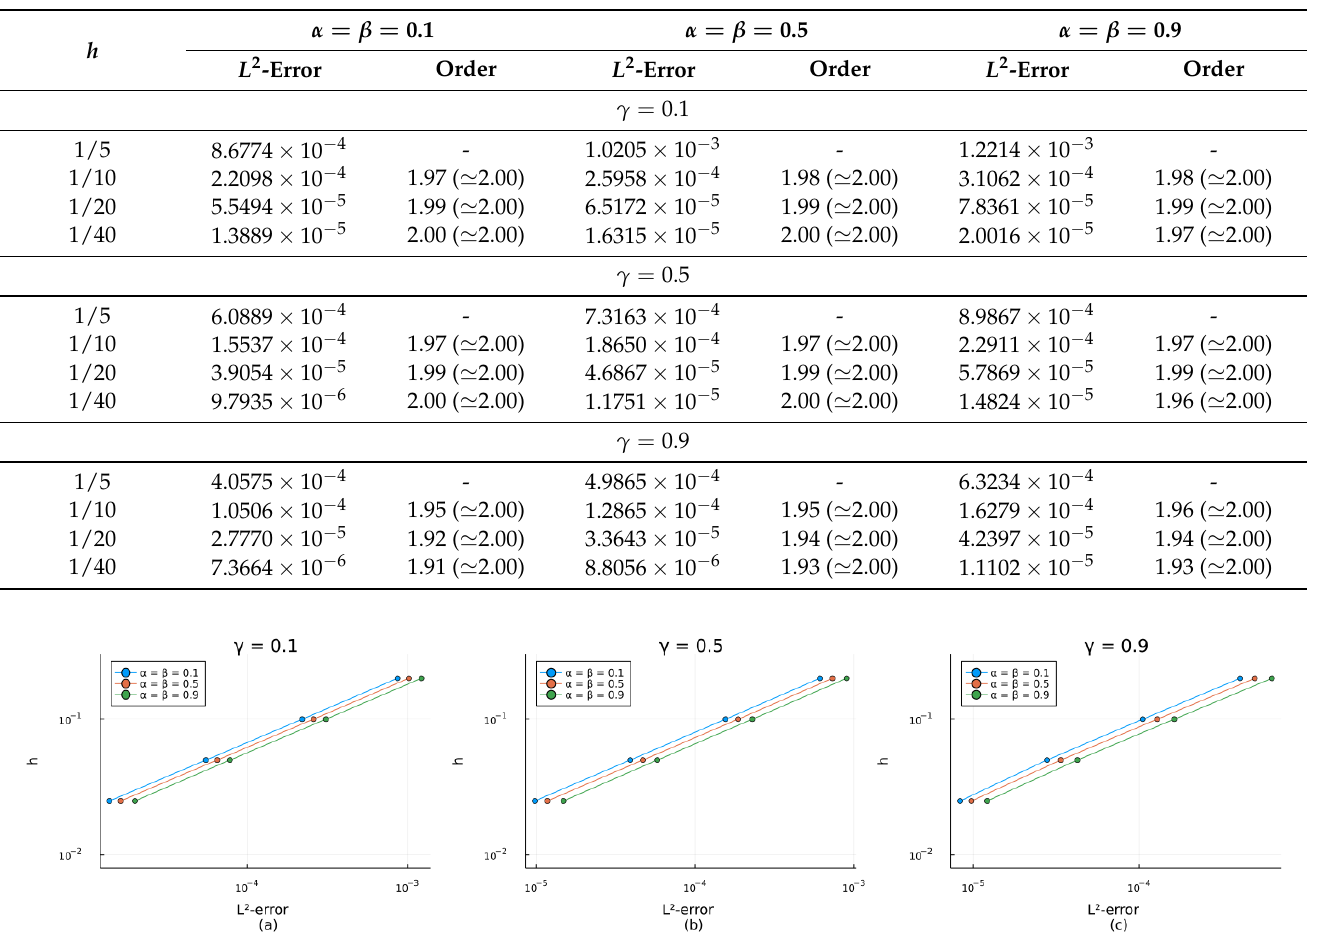
Figure 2. Error plots with respect to the mesh size h obtained for Example 1 with τ = 1/20,000 and different orders of fractional derivatives: α ∈ { 0.1,0.5,0.9 } ; β = α ; ( a ) γ = 0.1. ( b ) γ = 0.5. ( c ) γ =